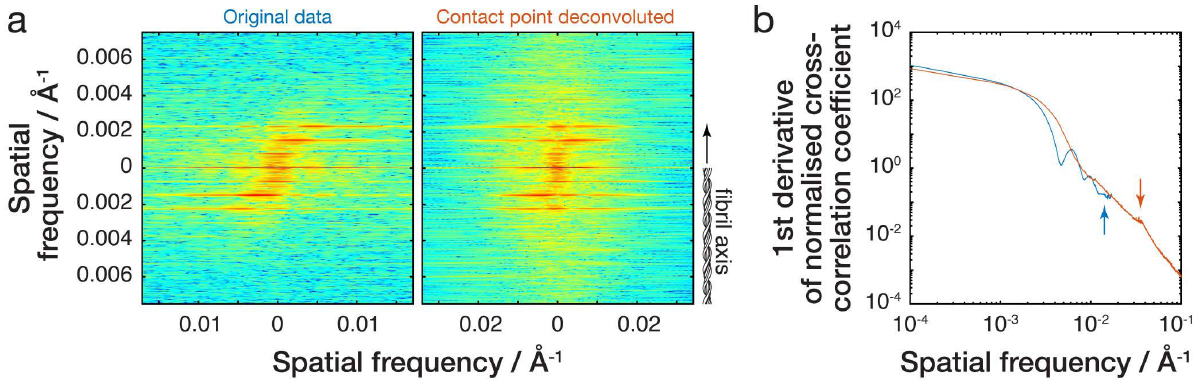
Figure 5: Resolution of original recorded and corrected AFM topographs are evaluated by the feature-based lateral resolution assessment method [28]. The same fibril image as Figure 4 is used as example. (a) 2D Fourier spectra of the original convoluted (left) and contact-point deconvoluted (right) images. The x-scale is expanded to accommodate peaks in the spectra for contact-point deconvoluted image as they are shifted to higher spatial frequencies. (b) Log-log plot of the first derivative of the normalised cross-correlation curve. Arrows indicate right-most peaks indicating the highest spatial frequency information present at 64Å resolution for the original convoluted fibril image and 28Å for the contact-point deconvoluted